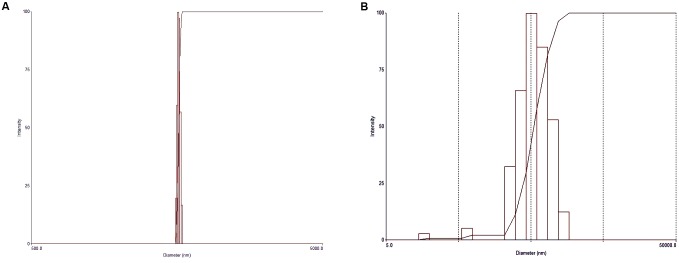
Particle sizes of (A) HANPs and (B) AgNPs.